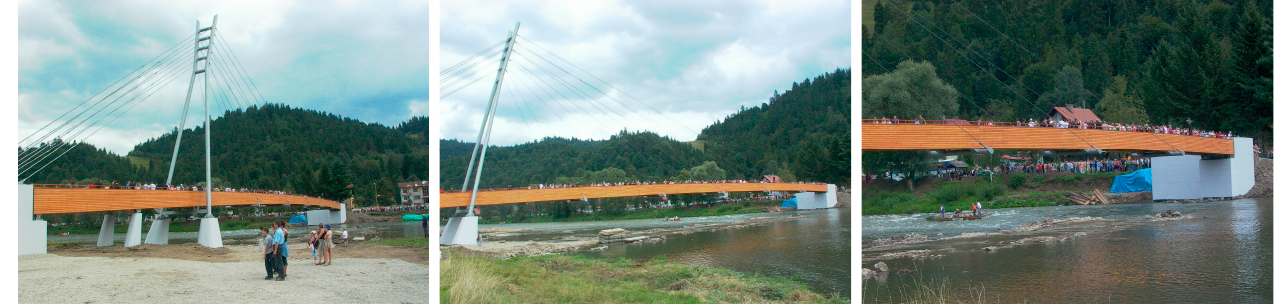
Figure 30. Snapshots of the crowd moving along the footbridge in the Pieniny mountains (direction Poland–Slovakia).